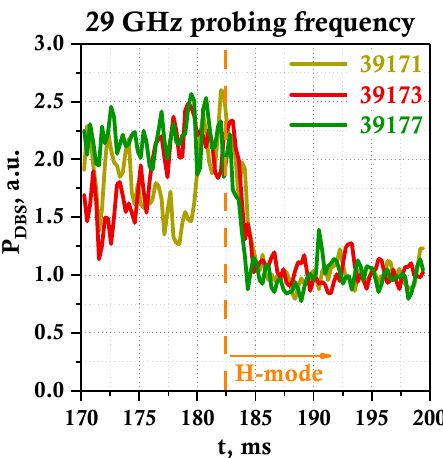
Figure 10. Temporal evolution of DBS power for 29 GHz probing frequency for discharges #39171, #39173, and #39177.